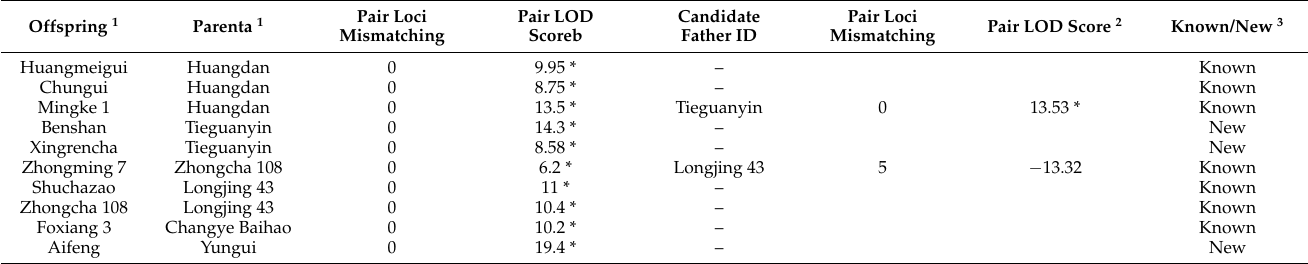
Table 3. Putative parentage revealed by the fingerprinting data of the 45 SNP markers.